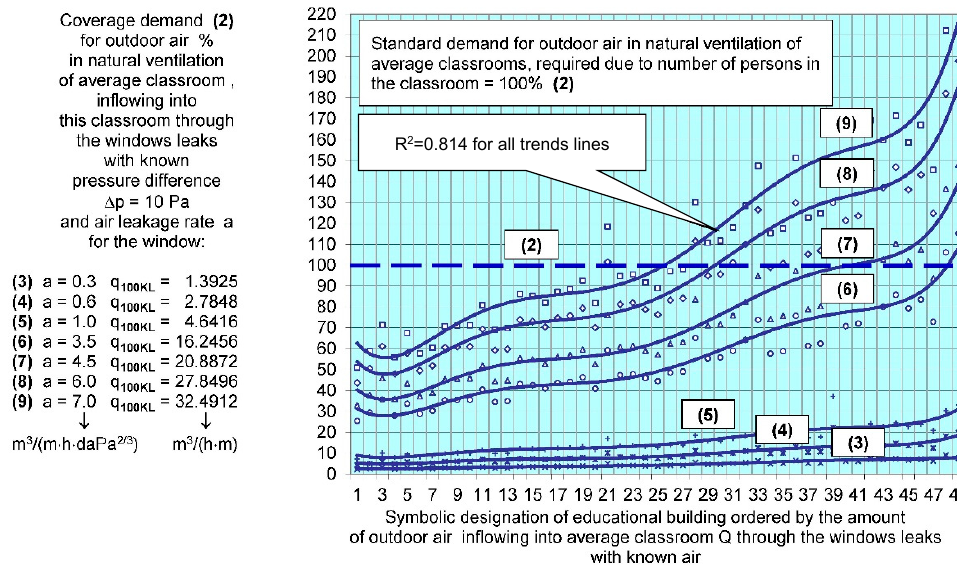
Figure 16. Coverage of the demand for sufficient (with respect to the requirements) quantity of air flowing into the classroom from the outside through the windows with different rates of outdoor air leakage a , in m 3 /(m · h · daPa 2/3 ) and their corresponding outdoor air permeability q 100KL in m 3 /(h · m) for Δ p = 10 Pa.